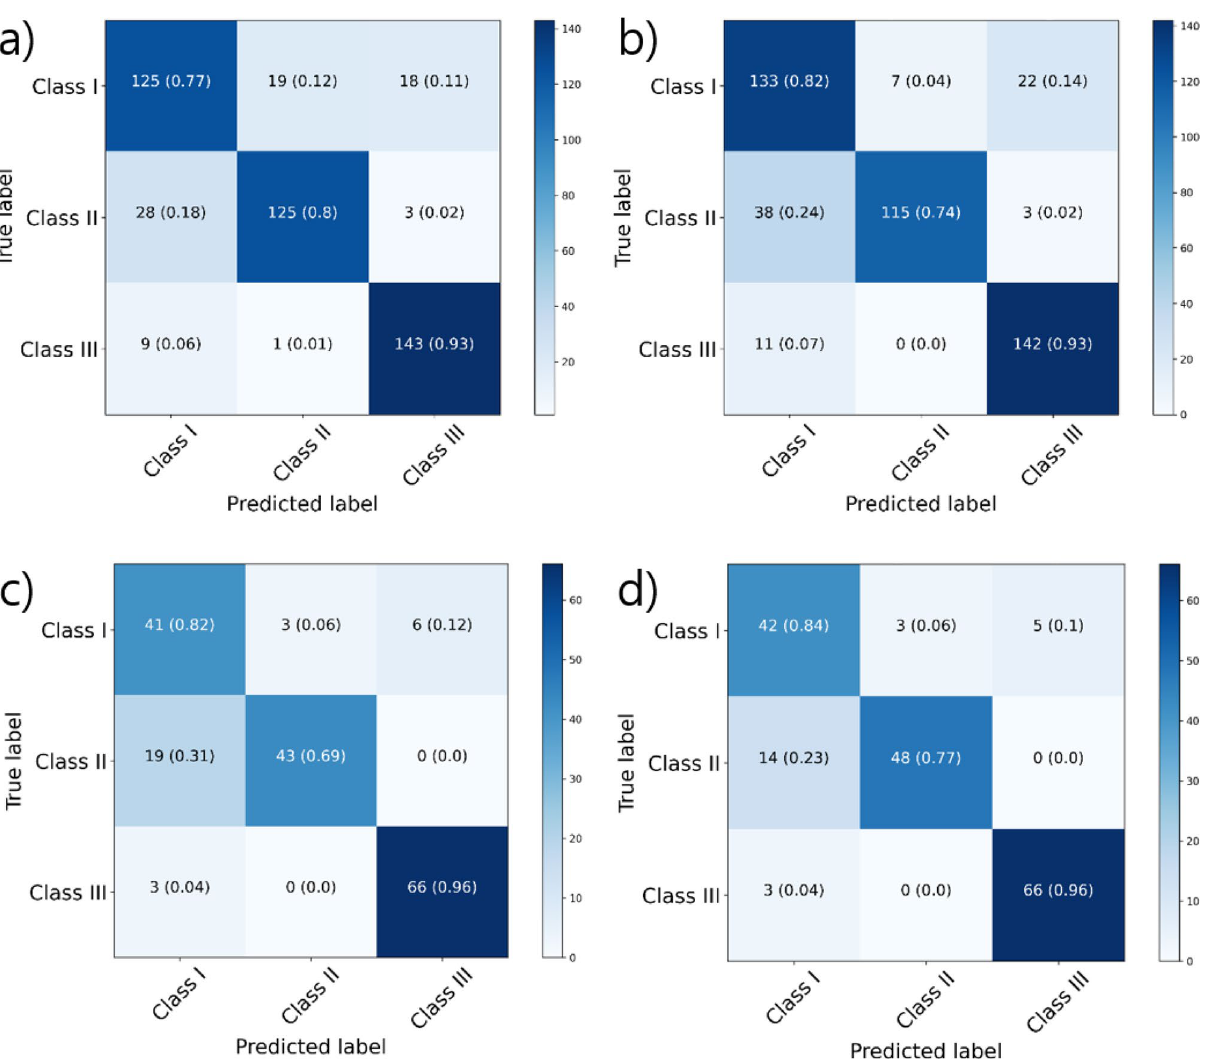
Figure 4. Confusion matrices of classification task for internal ( a,b ) and external ( c,d ) datasets. Left: performance of trained model using only the real dataset. Right: performance of trained model using the real dataset and synthesized